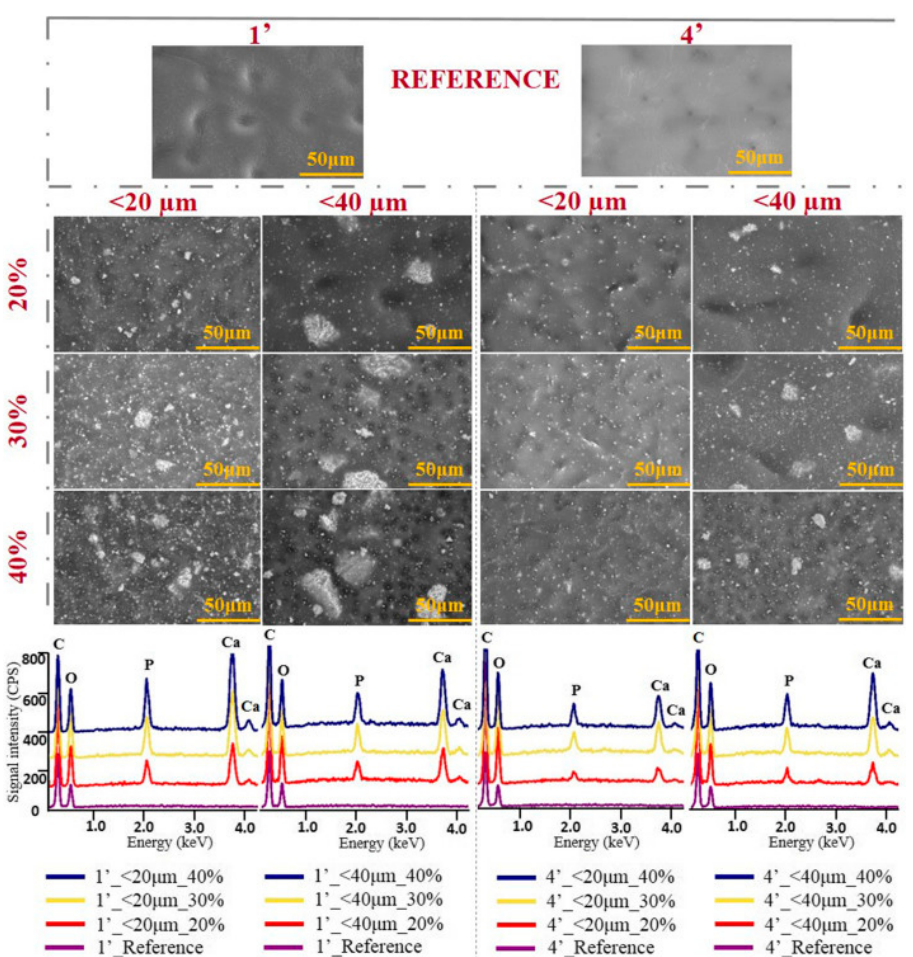
Figure 8 . The influence of the three key synthesis parameters—ultrasonic dispersion time, hydroxyapatite particles size, and powder concentration—on the morpho-compositional features of the composite cellulose acetate/hydroxyapatite membranes ( reproduced with permission from Ref.